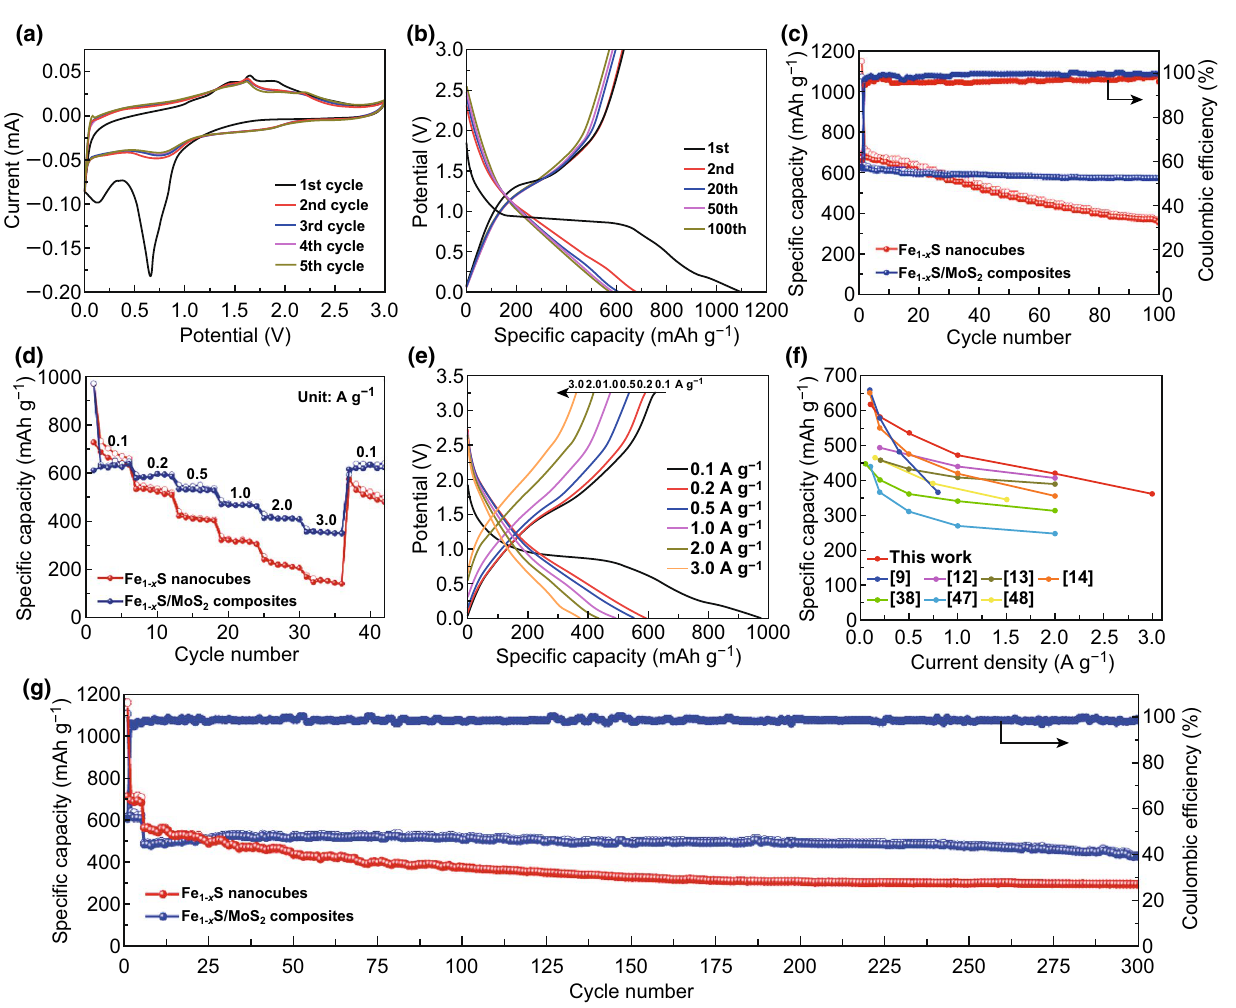
Fig. 2 a CV curves of Fe 1− x S/MoS 2 composite electrode for the first five cycles. b Galvanostatic charge–discharge profiles of Fe 1− x S/MoS 2 composite electrode at 100 mA g −1 . c Cycling performance at 100 mA g −1 . d Rate capability at various current densities. e Galvanostatic charge–discharge profiles of Fe 1− x S/MoS 2 composite electrode at various current densities. f The comparison of the rate capability with other iron sulfide-based anode materials previously reported [9, 12–14, 38, 55, 56]. g Long-term cycling performance at 1.0 A g